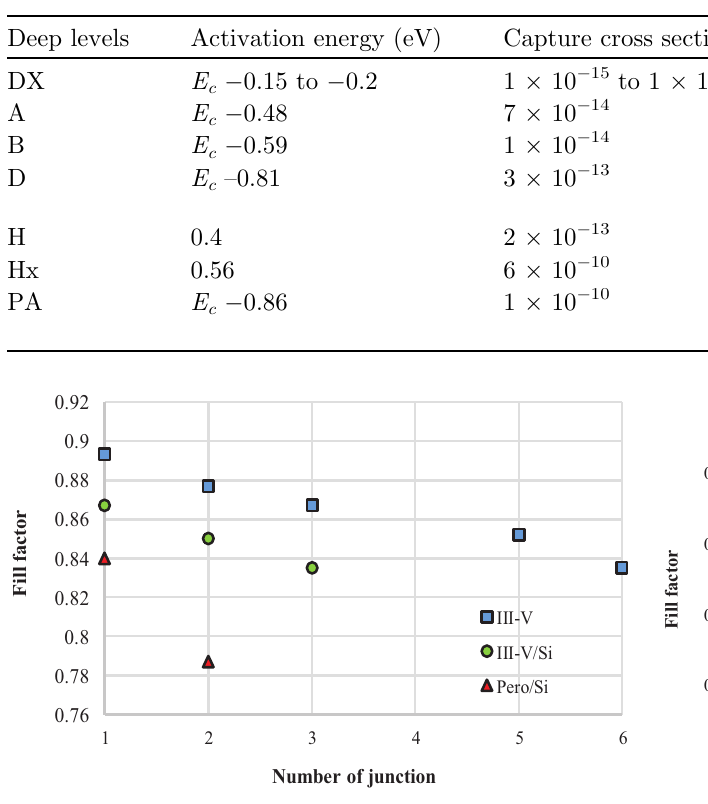
Fig. 9. Correlation between fi ll factor and contact resistivity of perovskite single-junction and perovskite/Si 2-junction solar